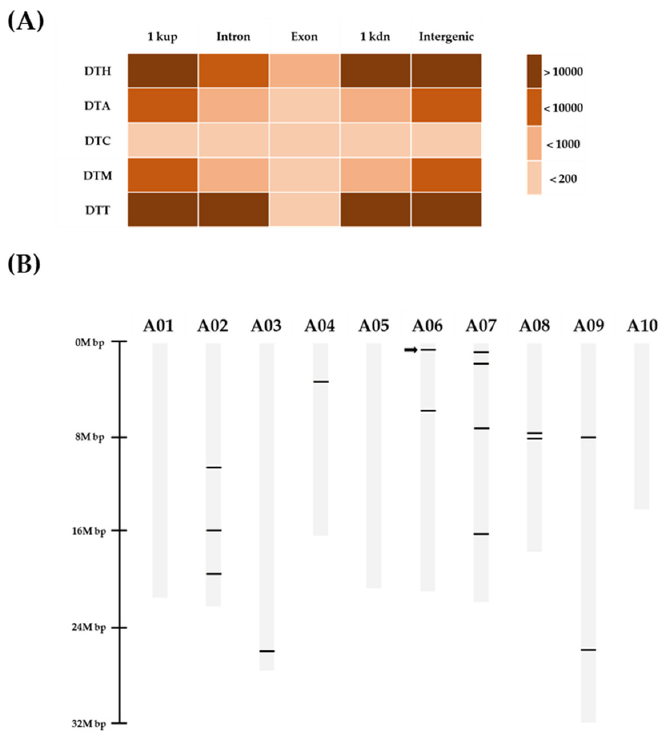
Figure 4. In silico mapping of PTE-2 and copy elements in ‘CT001’ genome. ( A ) Distribution of MITE family in ‘CT001’ genome. DTT, Tc1/mariner ; DTH, PIF/Harbinger ; DTA, hAT ; DTM, Mutator ; DTC, CACTA ; and DTP, P element . 1kup, 1k bp upstream from gene locus; 1kdn, 1k bp downstream from gene locus. ( B ) Location of PTE-2 and copy elements in ‘CT001’ genome. Black bar, PTE-2 and copy elements; Black arrow, PTE-2 position.